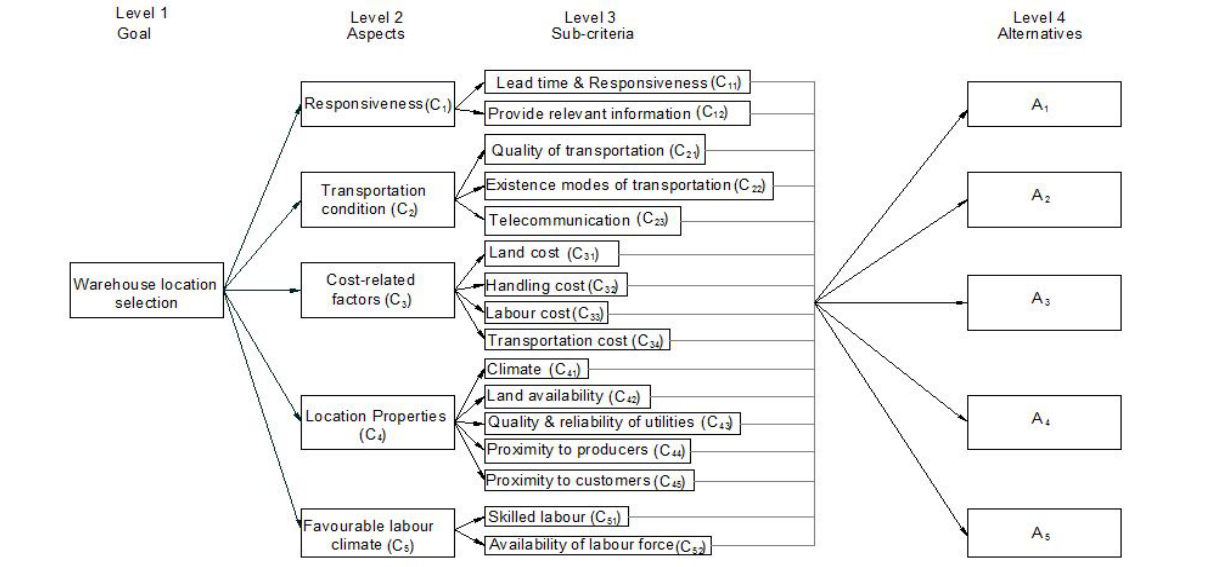
Fig. 4. The hierarchy structure of warehouse location selection